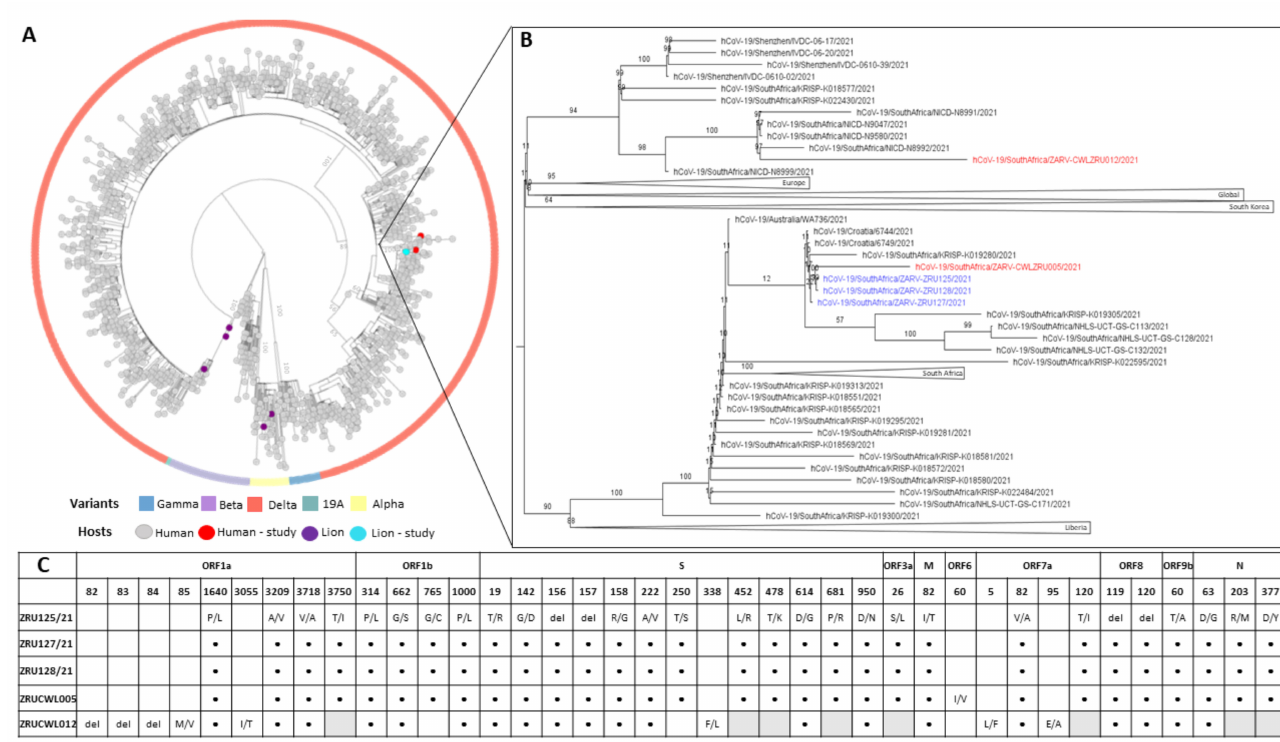
Figure 3. ( A ): Maximum likelihood tree of global SARS-CoV-2 genomes. Variants of concern are indicated in the outer circle and host species are indicated by coloured tips. ( B ): View of branch where SARS-CoV-2 sequences determined in this study clustered. Sequences from lions are in blue and sequences from humans are in red: ZRU125/21 (EPI-ISL-6261983), ZRU127/21 (EPI-ISL- 6261987), ZRU128/21 (EPI-ISL-6261989), ZRUCWL005 (EPI-ISL-6261993) and ZRUCWL012 (EPI-ISL- 6261996). ( C ): Amino acid changes in study strains when compared to the Wuhan-Hu-1 reference genome (NC_045512.2). Black dots represent identical changes and grey boxes represent missing data. Sequencing was done from NP